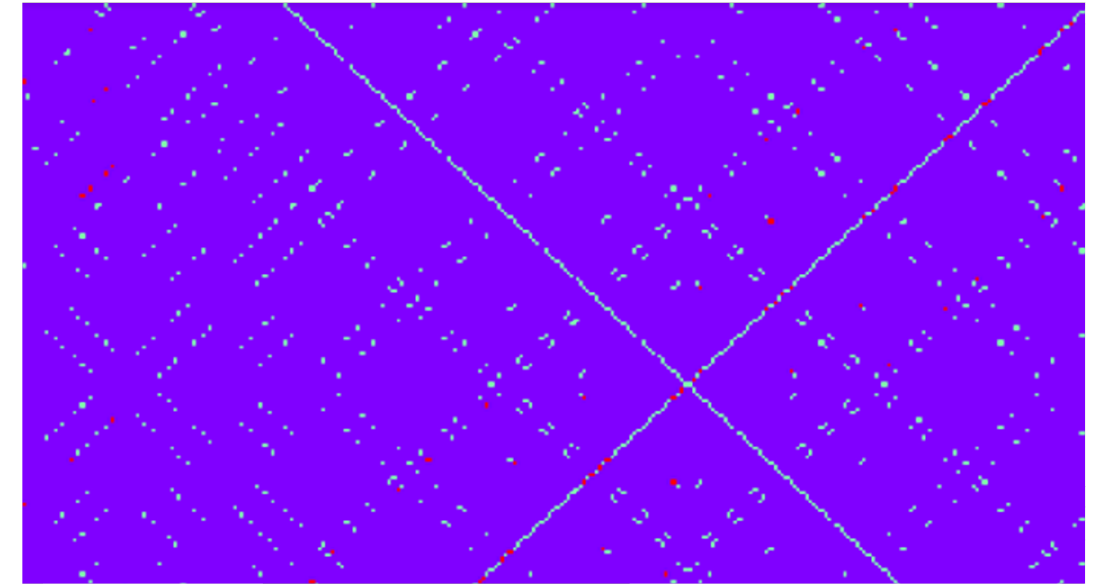
Figure 20. Greatest Common Decision Maker details for 4 × 4 matrices.